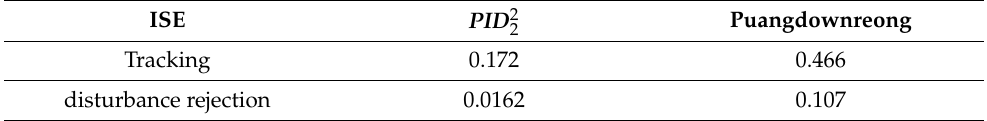
Table 9. The ISE values for both controllers in tracking and disturbance